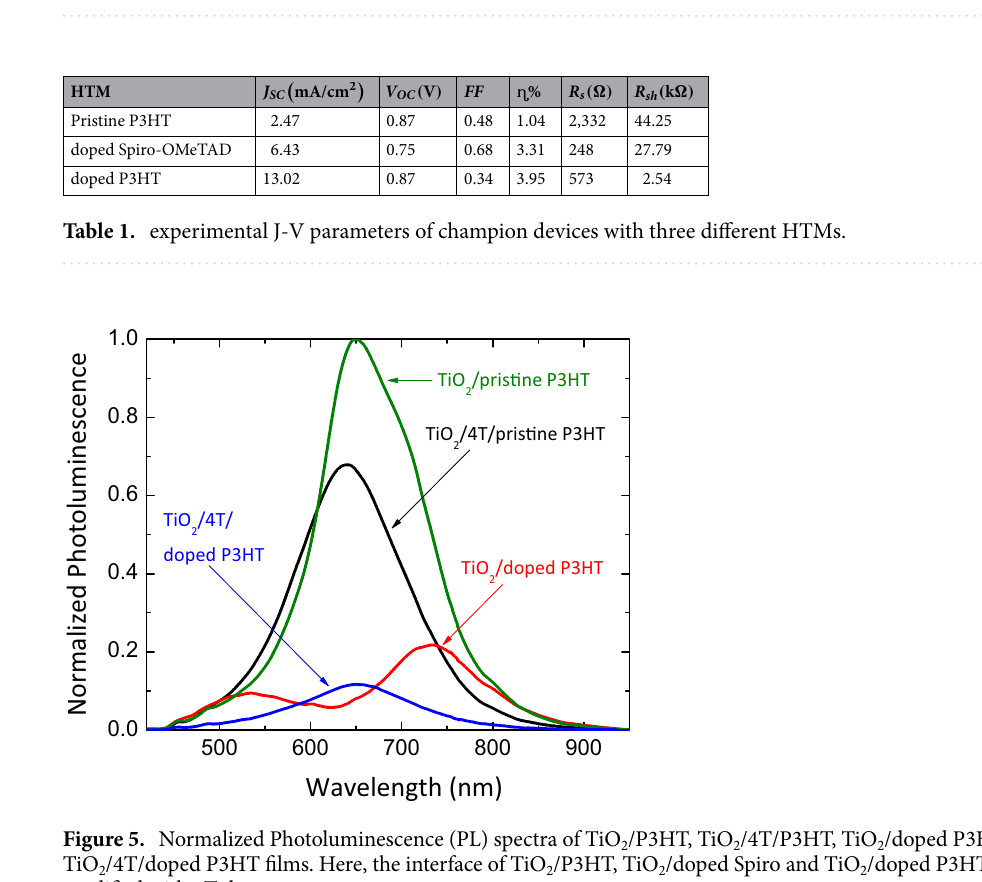
Figure 4. External quantum efficiency (EQE) of ITO/TiO 2 /4T/HTM/Au solar cells. Here, the 4T dye is used as an interface modifier and HTMs are pristine P3HT, doped P3HT and doped Spiro-OMeTAD.